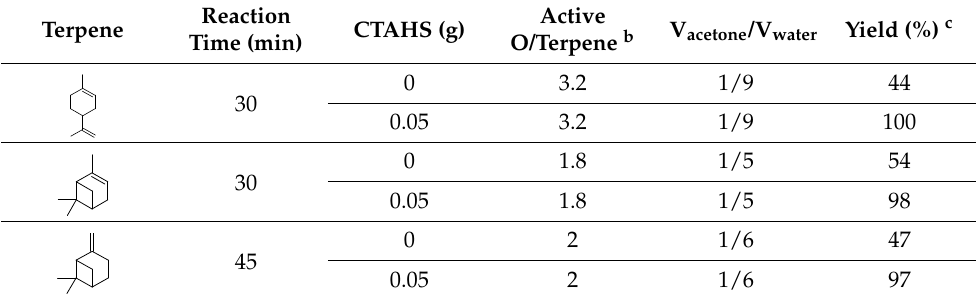
Table 3. Effect of CTAHS on terpene epoxidation a . Reaction Terpene